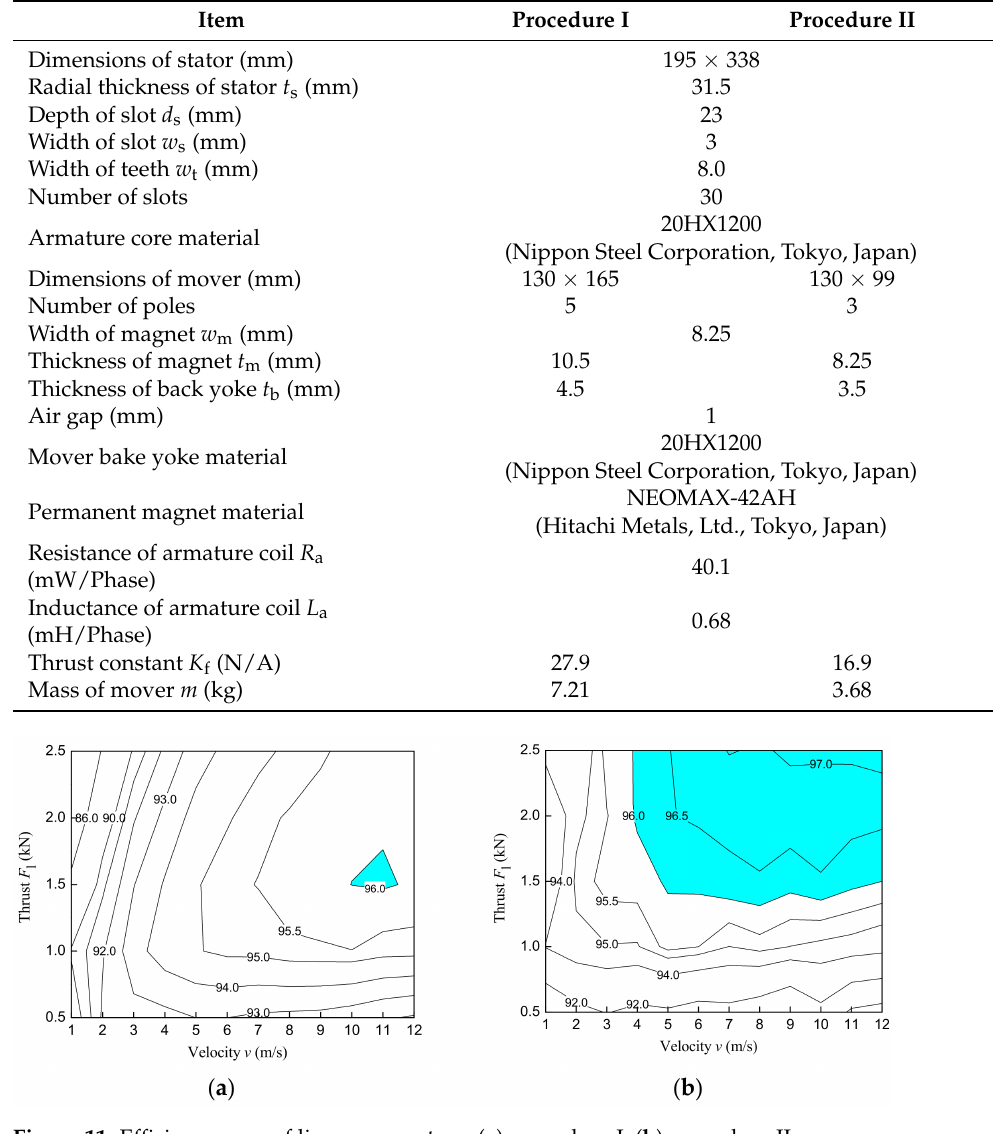
Figure 11. Efficiency map of linear generators: ( a ) procedure I, ( b ) procedure II.